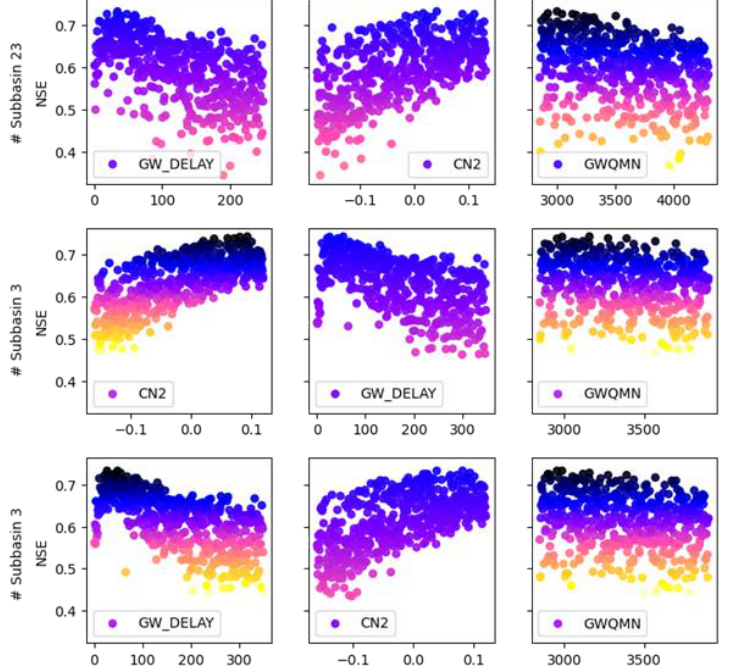
Figure 6. Dotty plots of the coefficient of NSE against SWAT parameters (left columns represent the most sensitive) using SUFI2 based on 500 samples from the Gecha watershed. (Note that # Subbasins 23, 3, and 3 account for 2%, 10%, and 20% of the Gecha watershed area, respectively.).